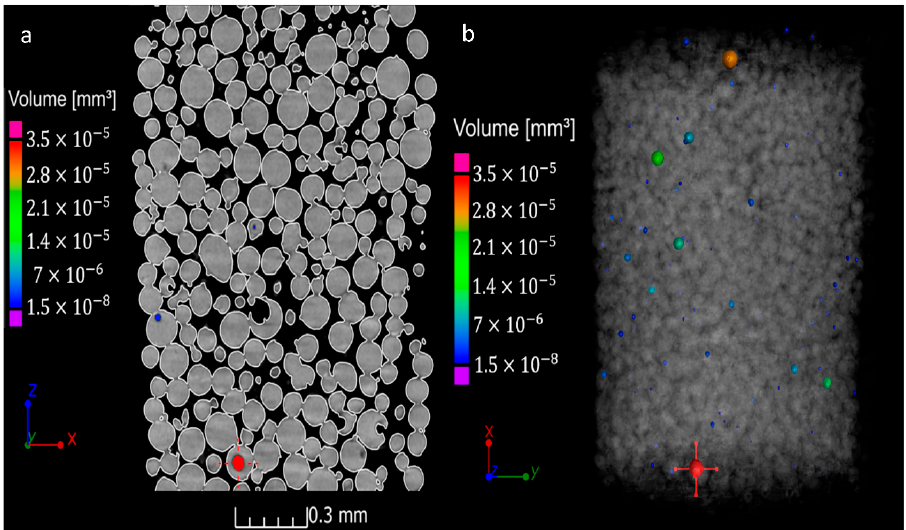
Figure 3. Embedded pores identification in Ti6Al4V powder by means of porosity module: front view slice ( a ) and 3D reconstruction of Ti6Al4V powder showing the identified embedded pores in the particles ( b ).